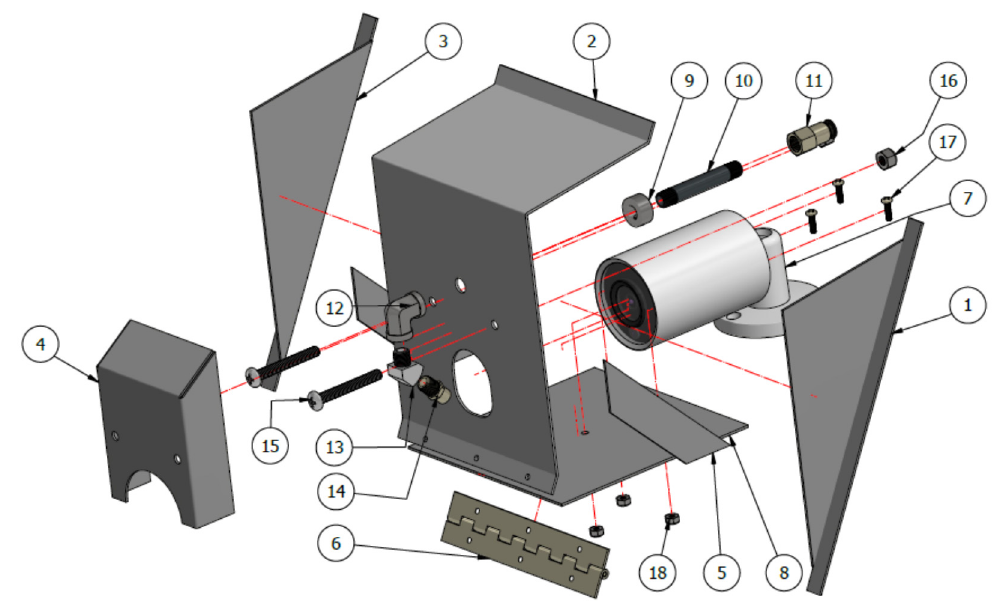
AgriEngineering 2020 , 3 FOR PEER REVIEW Figure 9. Module feeder camera housing assembly drawing. Figure 9. Module feeder camera housing assembly drawing.